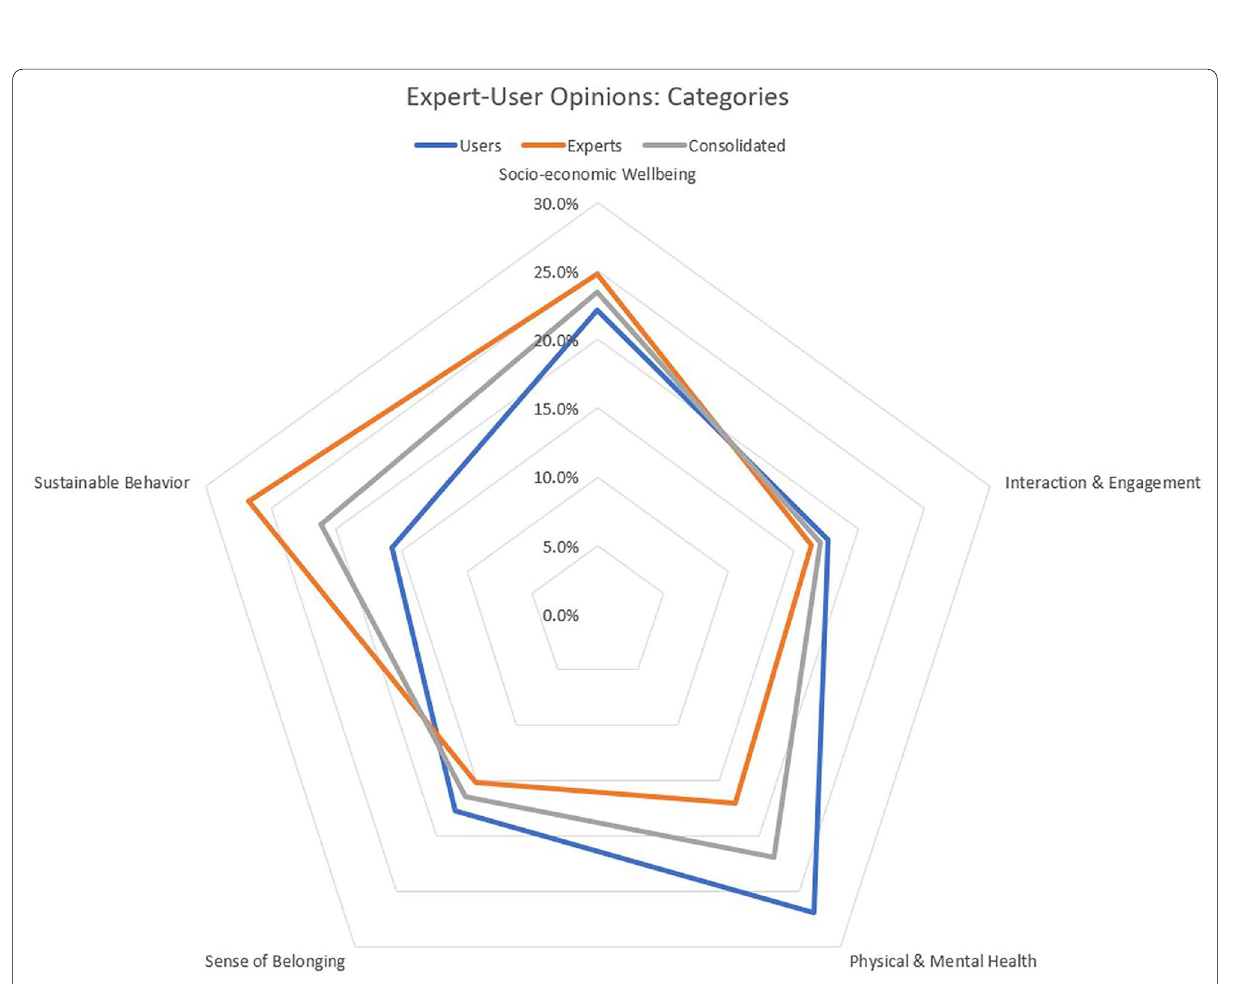
Fig. 4 Comparison between experts and users’